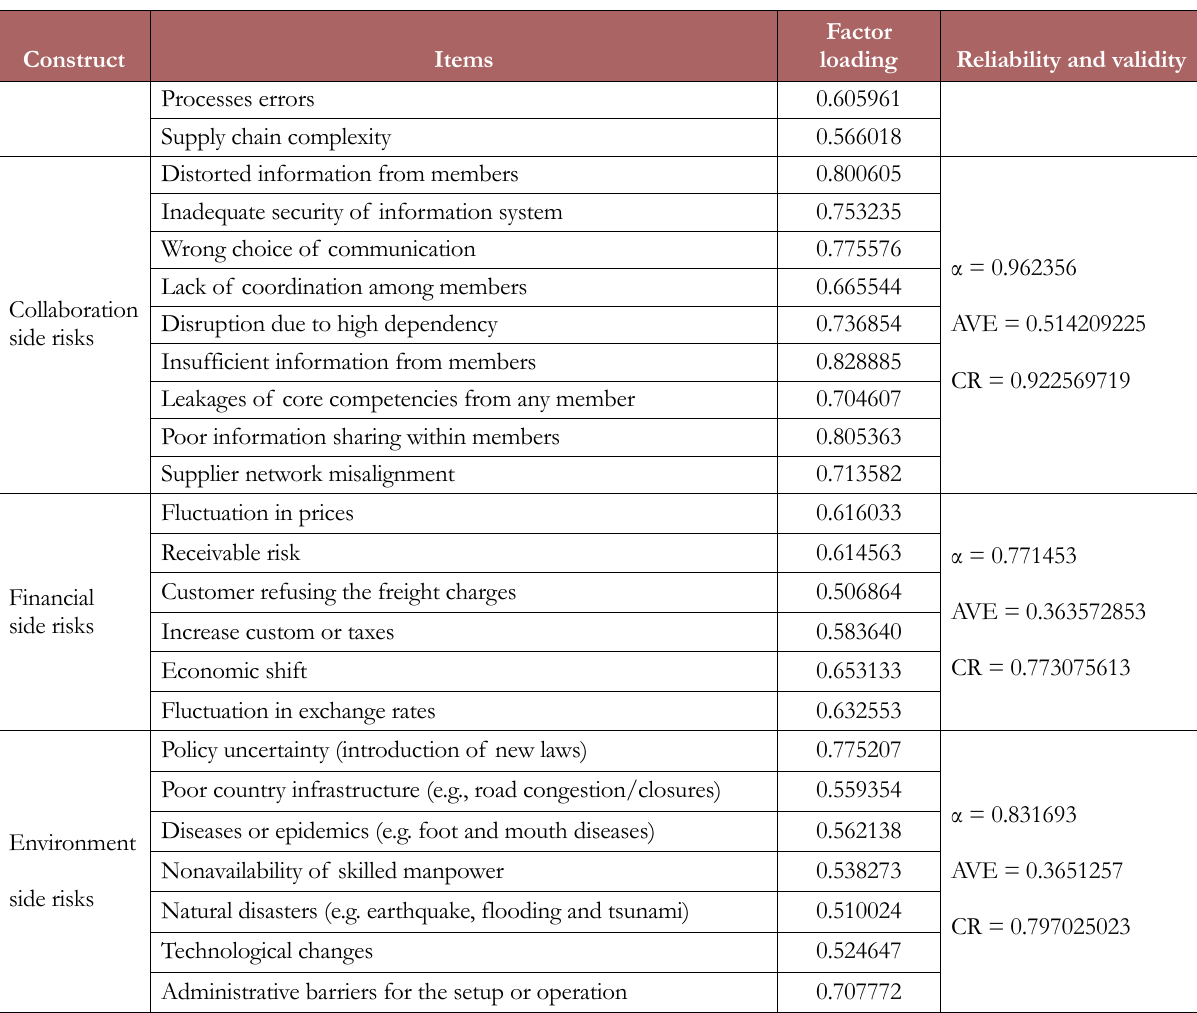
Table 3. Reliability and